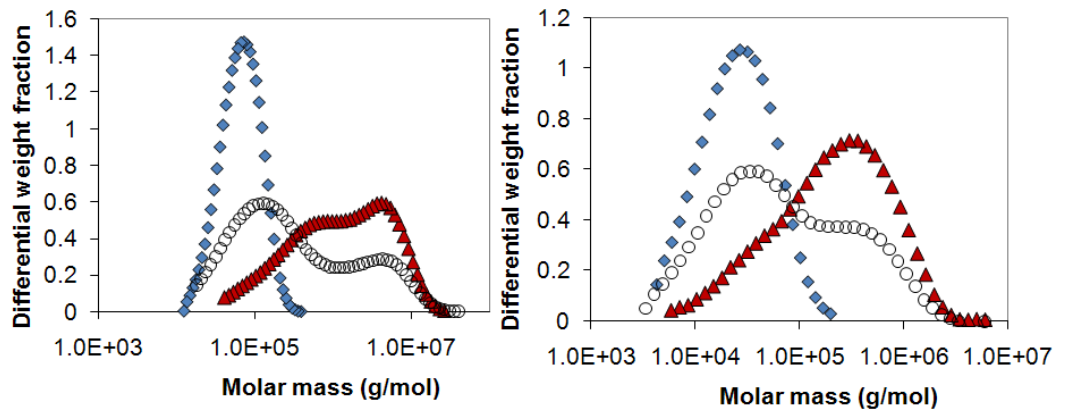
Figure 11. The molecular weight distribution of a mixed 50:50 sample (open circles) together with the pure polymers used in the mixture, (a) dextran T70 (diamonds) and dextran T2000 (triangles) and (b) HPMC 60SH6 (diamonds) and HPMC 60SH10000